Question: Is the quantity shown trending increasing or decreasing?
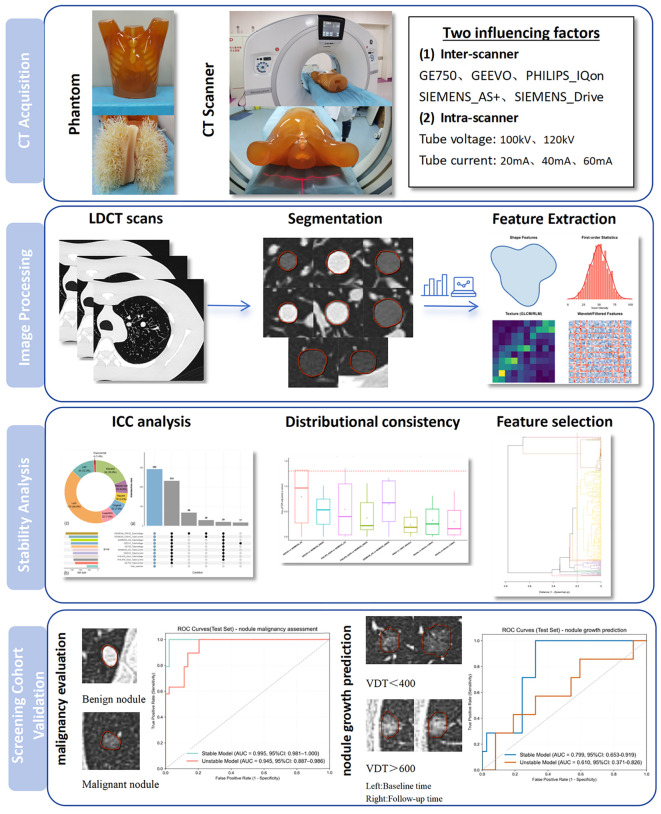
Answer: increasing